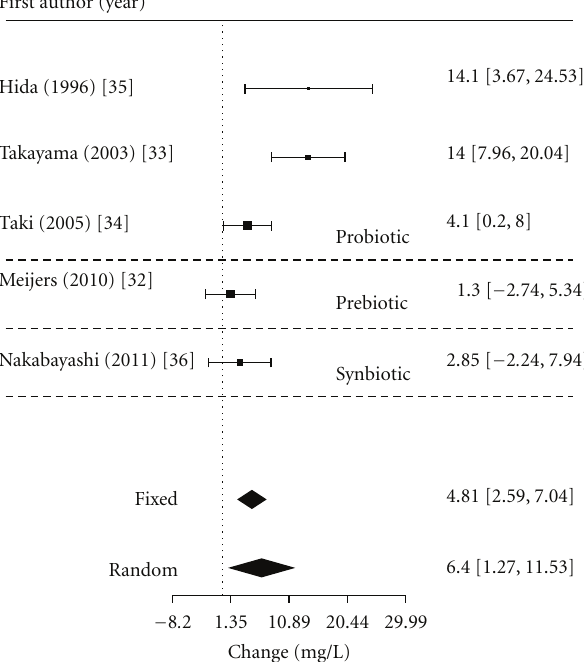
Figure 2: Meta-analysis for pre-, pro-, and synbiotic therapy on serum IS in the HD